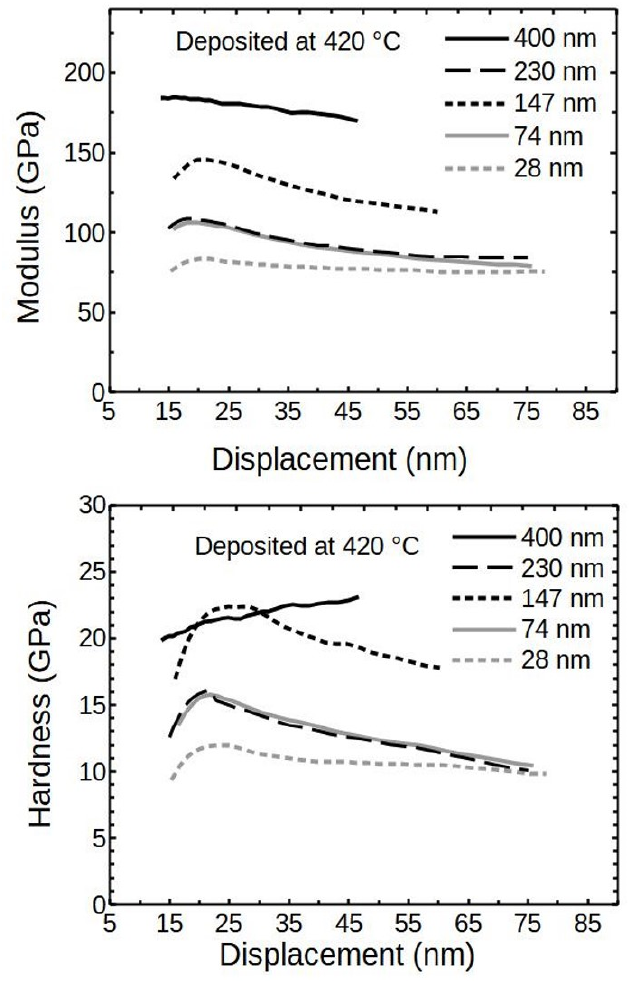
Figure 8. Modulus and hardness of ALD Cr 2 O 3 thin films deposited at 420 °C.